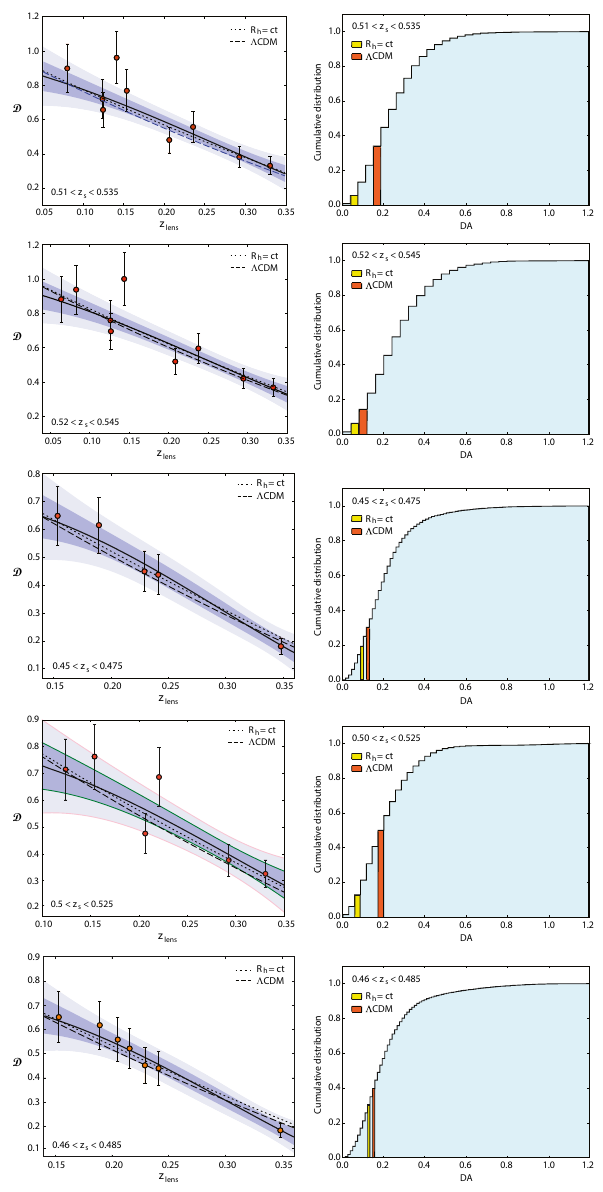
Fig. 2 Left panels a , c , e , g , i The solid curve in each plot indicates the reconstructed D obs function using Gaussian processes, for the source redsfhitranges ( 0 . 51 , 0 . 535 ) , ( 0 . 52 , 0 . 545 ) , ( 0 . 45 , 0 . 475 ) , ( 0 . 5 , 0 . 525 ) , and ( 0 . 46 , 0 . 485 ) . The dotted curve indicates the predicted D in the R h = ct universe and the dashed curve indicates the corresponding D in Λ CDM. In each of these figures, dark blue represents the 1 σ confidence region, and light blue is 2 σ . Right panels b , d , f , h , j The corresponding cumulative probability